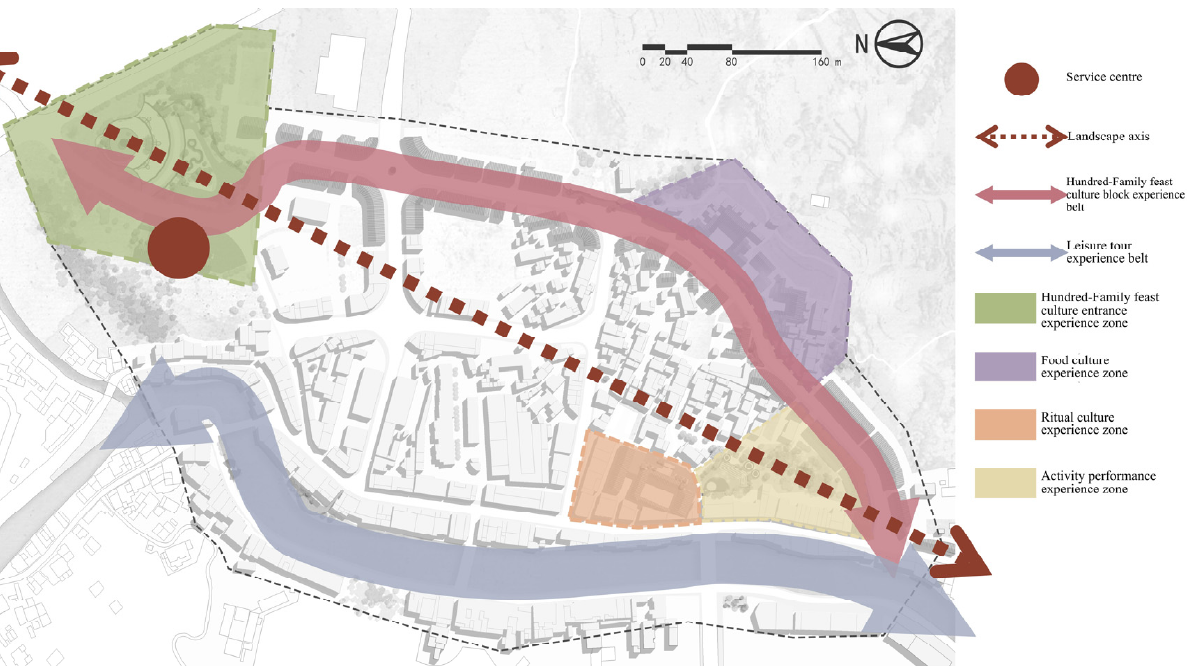
Figure 6. General layout of Taishun Hundred-family Feast landscape presentation.